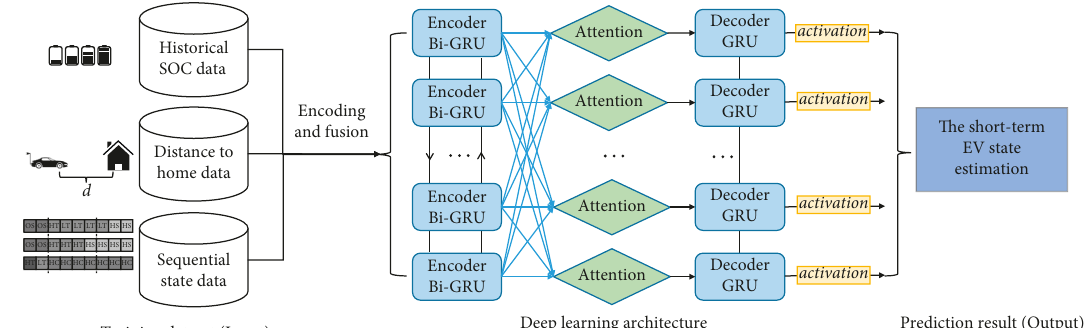
Figure 2: Bidirectional GRU with attention